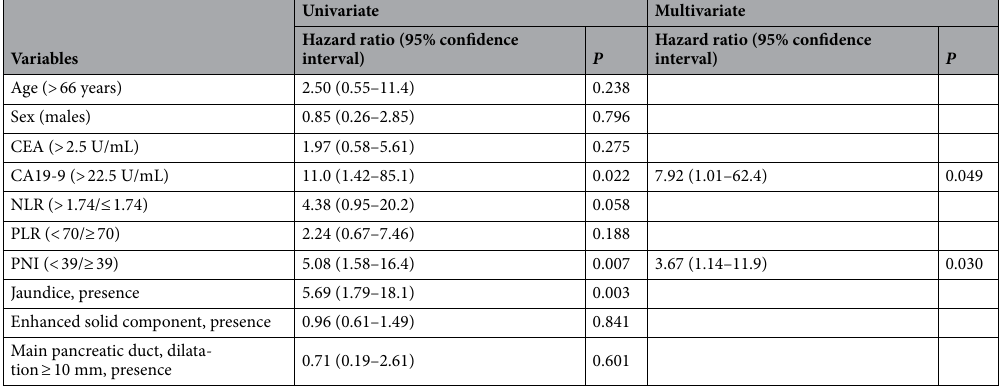
Table 4. Preoperative prognostic factors for the disease-specific survival in patients with invasive IPMC. IPMC intraductal papillary mucinous carcinoma, CEA carcinoembryonic antigen, CA carbohydrate antigen, NLR neutrophil-to-lymphocyte ratio, PLR platelet-to-lymphocyte ratio, PNI prognostic nutritional index.